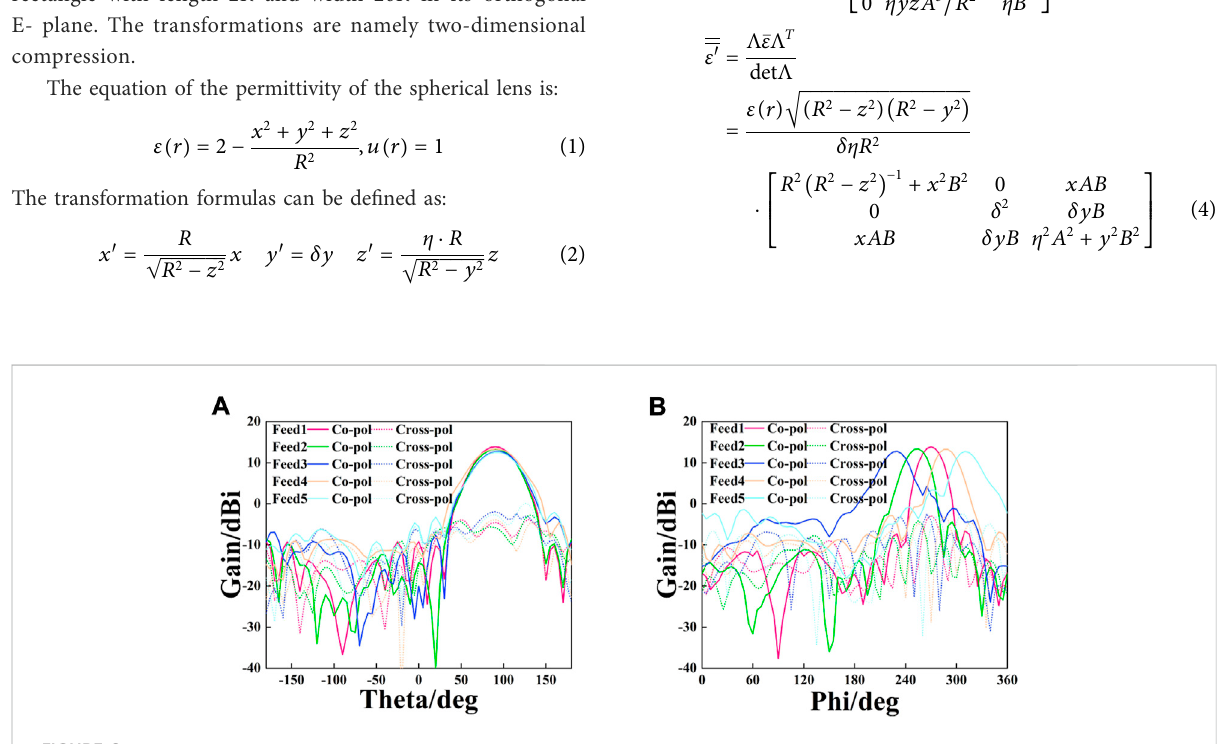
FIGURE 6 Simulated radiation patterns for +45 ° pol at 3.3 GHz. (A) E-plane. (B)